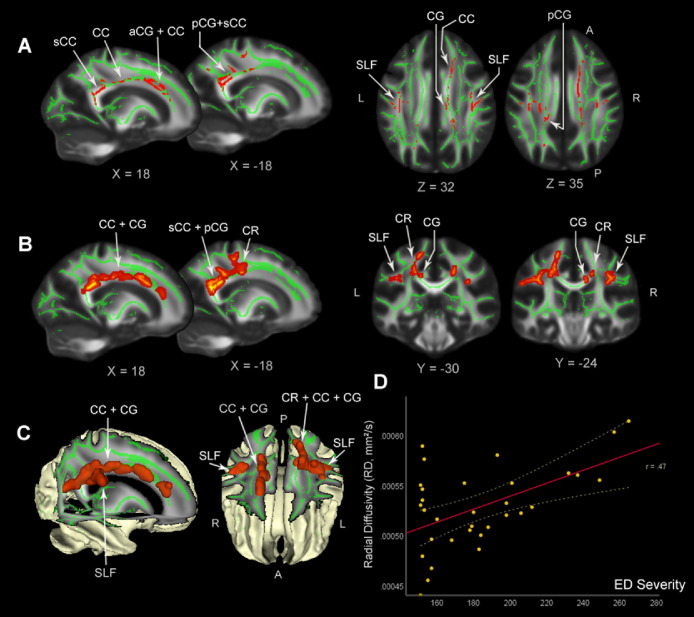
TBSS whole-brain results of significant white matter regions positively correlated with emotional dysregulation characterized by CBCL-ED. (3A) The skeleton map red color shows where RD significantly and positively correlated with ED symptom severity along the cingulum (CG) and corpus callosum (CC), specifically including the anterior and posterior subdivisions of the cingulum (aCG; pCG) that are connected with the body and the splenium of corpus callosum (CC; sCC) and the anterior to superior corona radiata (CR), extending laterally into small clusters of the SLF. (3B) The significant brain areas are filled into the mean FA map to visualize implicated local tracts (red color). (3C) 3D rendering of the TBSS-significant filled images in standard template brain, where RD significantly showed a positive relationship with the severity of ED symptoms. All images are threshold with P < 0.05 voxelwise and corrected by multiple comparisons. The FMRIB58 1 mm standard FA template image is used for overlay display. The JHU DTI-based atlases are used (https://fsl.fmrib.ox.ac.uk/fsl/fslwiki/Atlases) to determine white-matter locations of significant results. (3D) Scatter plot visualizes mean RD values extracted from the significant brain regions (Y-axis) plotted against the CBCL-ED scores (X-axis, with 150 being the lowest obtainable ED score) and with the prediction line (middle line) and 95% confidence interval (curved lines). The plot shows that worse (higher) CBCL-ED scores are associated with higher values of RD. The Spearman's correlation coefficient of the relationship (rs) is displayed for illustrational purposes.